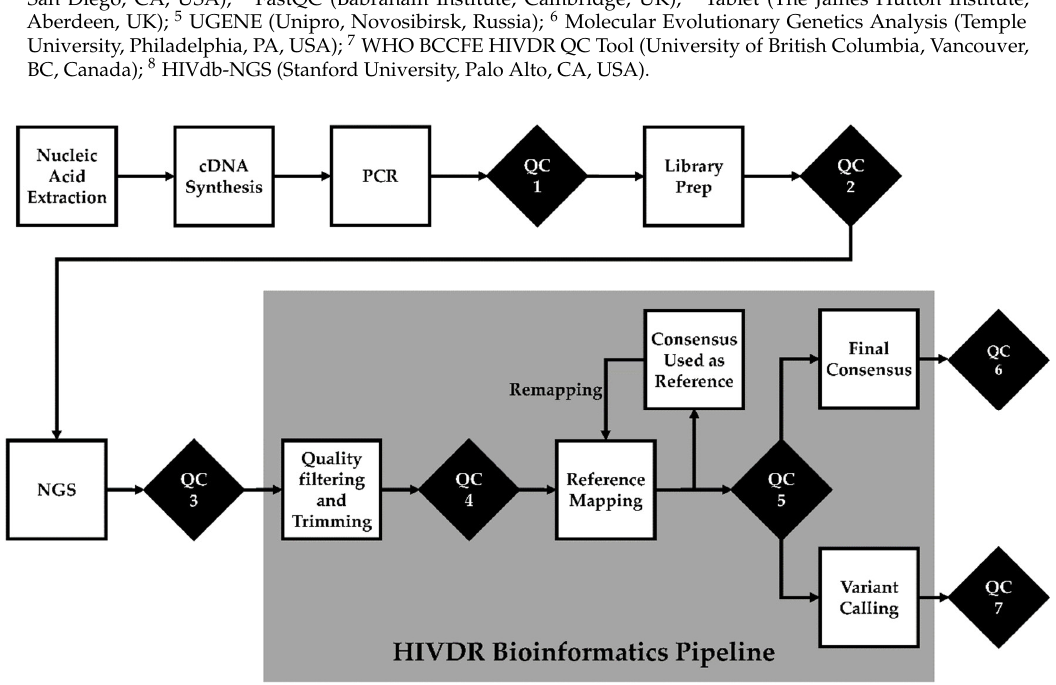
Table 1. A summary of performance metrics and thresholds at each quality control checkpoints.